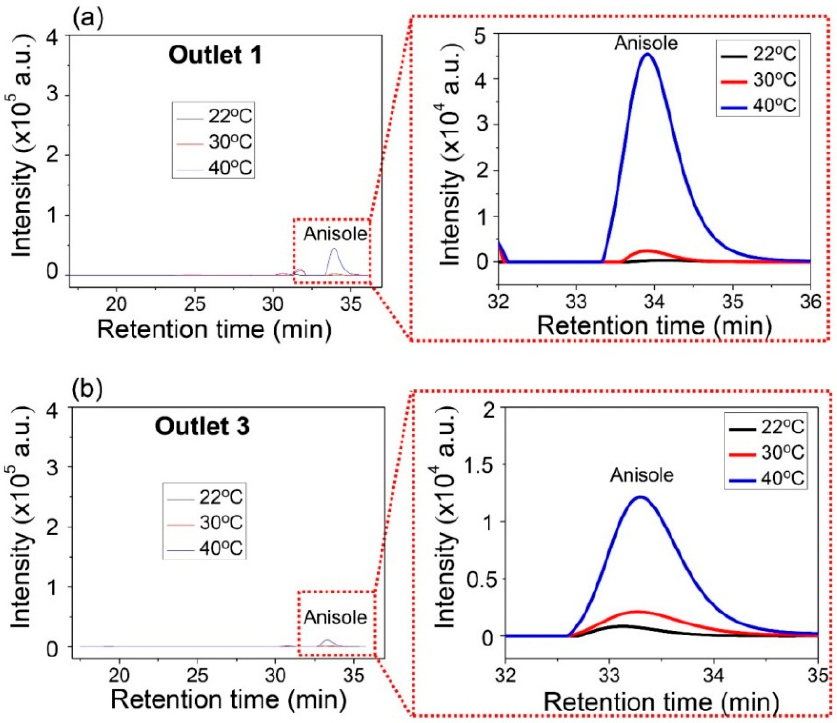
Figure 9. GPC results for the influence of temperature on separation at the same inlet flow rate of mixture and N , N -dimethylformamide (DMF) solvent: ( a ) GPC analysis of Outlet 1; ( b ) GPC analysis of Outlet 3.